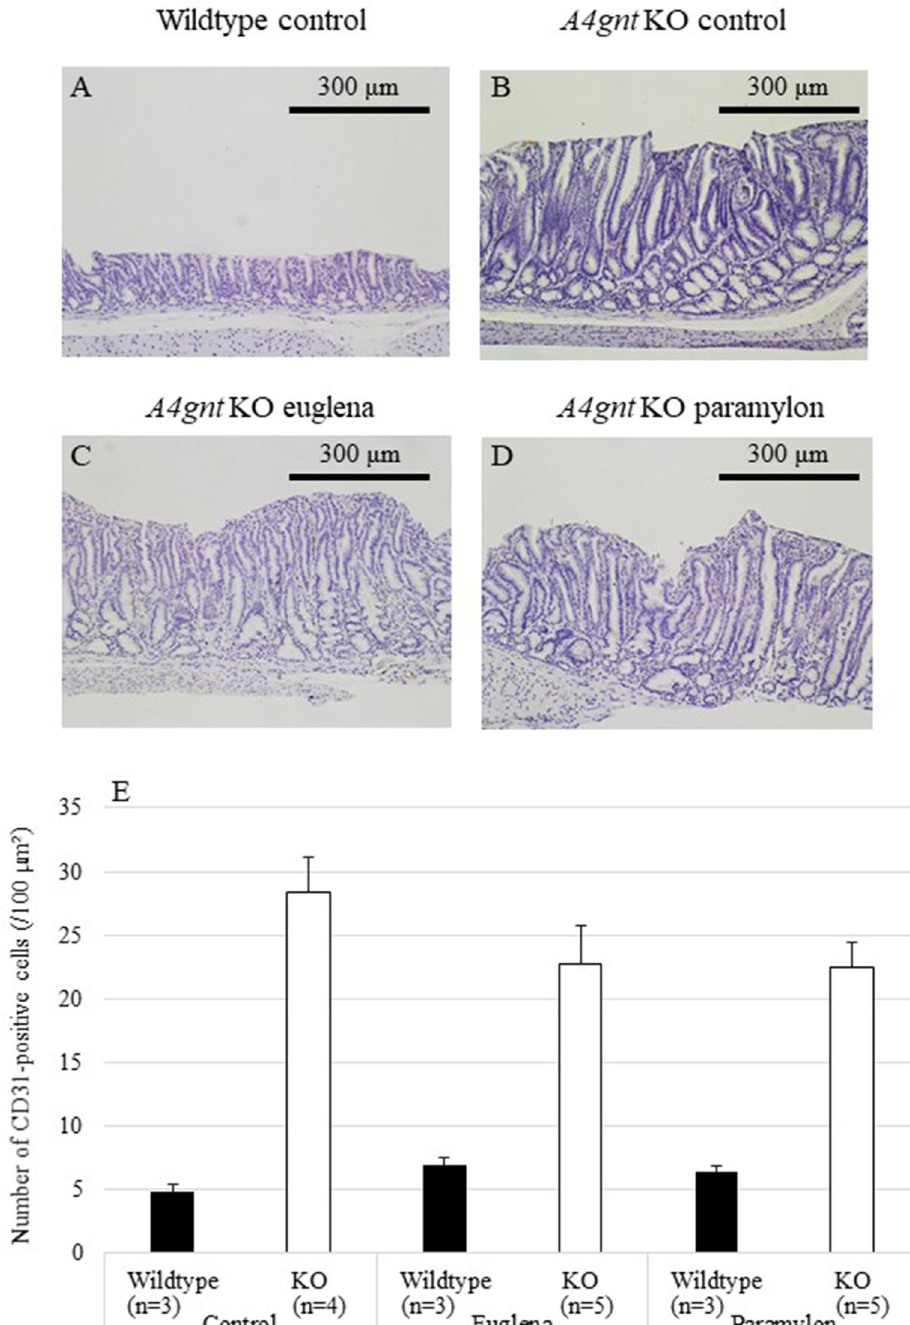
Figure 5. Numbers of CD31-positive cells in gastric mucosa of A4gnt KO and wildtype mice. ( A ) Wildtype mouse administered saline. ( B ) A4gnt KO mouse administered saline. ( C ) A4gnt KO mouse administered 50 mg/day of Euglena . ( D ) A4gnt KO mouse administered 50 mg/day of paramylon. CD31-positive cells were stained brown by diaminobenzidine tetrahydrochloride. ( E ) Mean ± SD of numbers of CD31-positive cells in pyloric mucosa. The mean numbers of CD31-positive cells in gastric mucosa of A4gnt KO mice was significantly more than that of wildtype mice. Administration of Euglena and paramylon did not affect the numbers of these